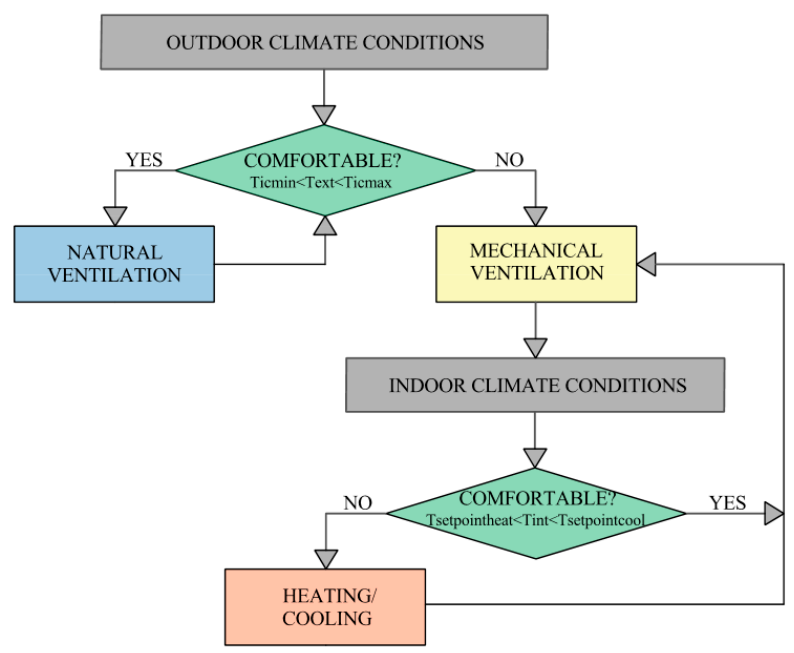
Figure 3. Algorithm for the operation of the HVAC systems.